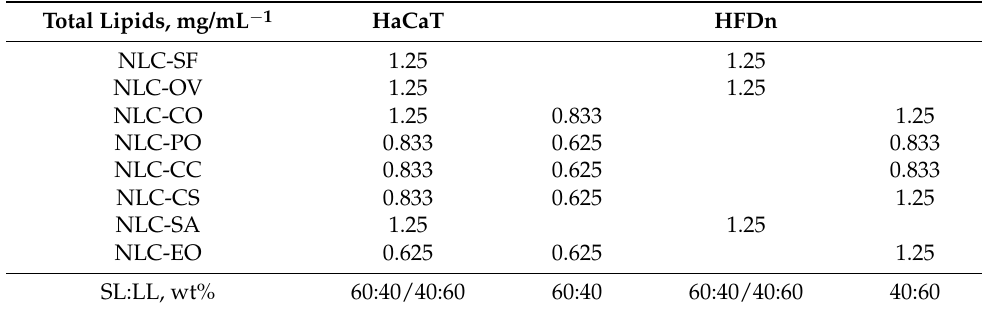
Table 5. Nontoxic total lipid concentration (mg/mL − 1 ) of NLC-NPOs for HaCaT and HFDn cell lines expressed by amount of total lipid (mg/mL − 1 ).